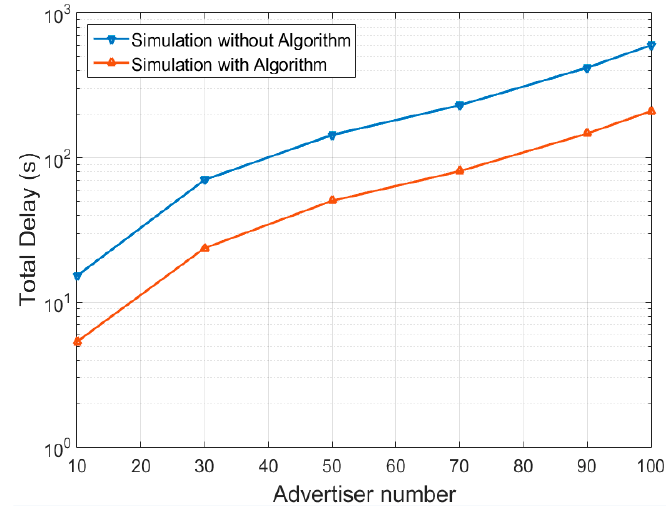
Figure 8. Total delay for advertiser discovery by the initiator.